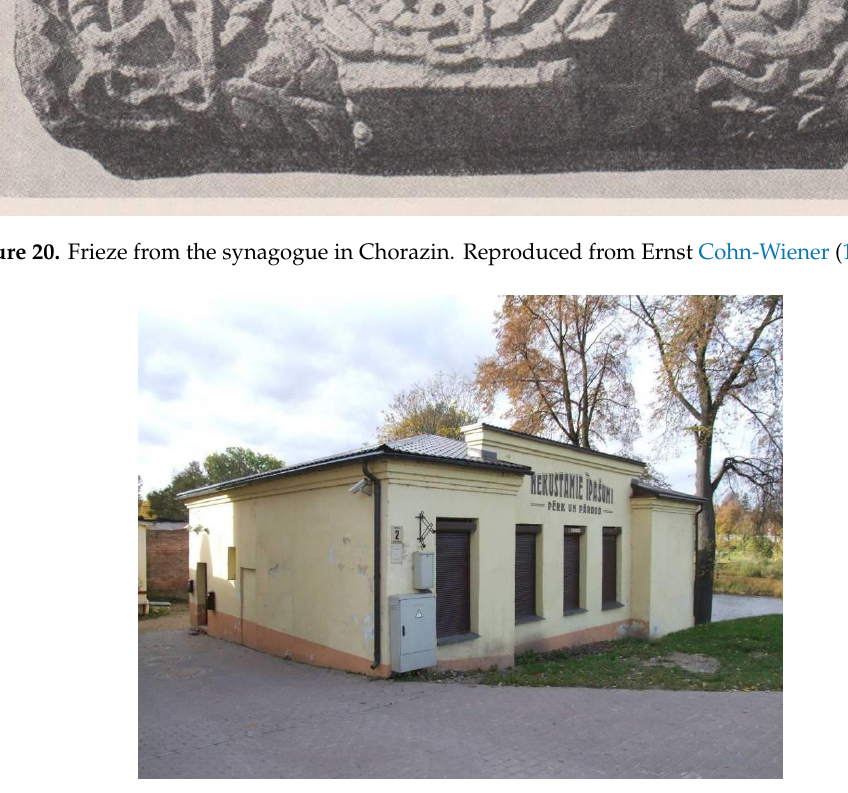
Figure 21. The former Hasidic Kloyz in Bauska, view from the southeast. Photo by the author, 2007. CJA.